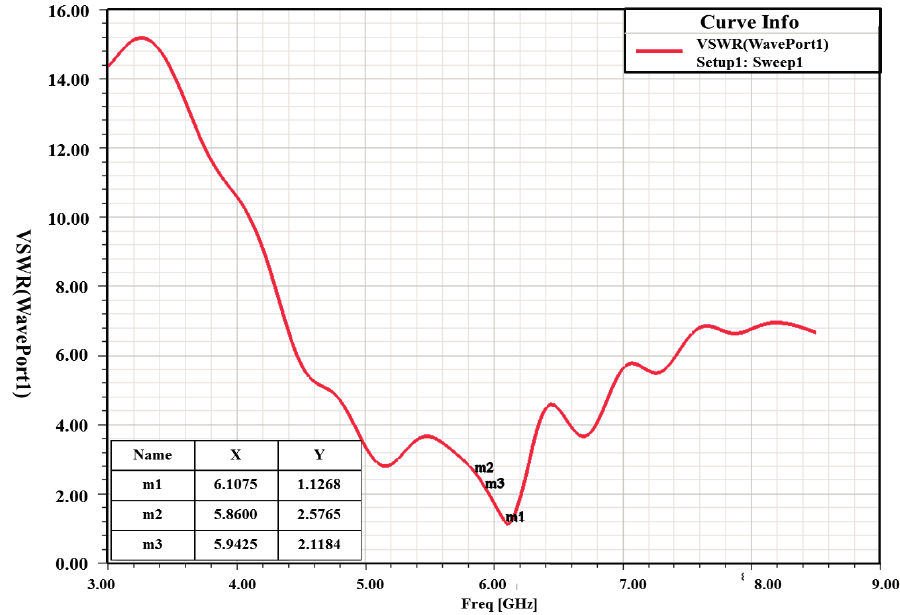
Figure 5. Simulation result of voltage standing wave ratio (VSWR).